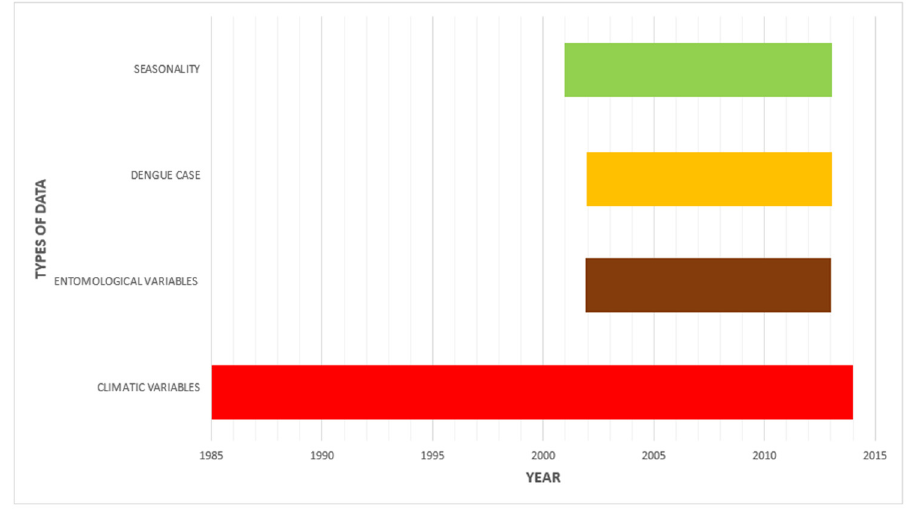
Figure 3. Overlapping time periods of different datasets.